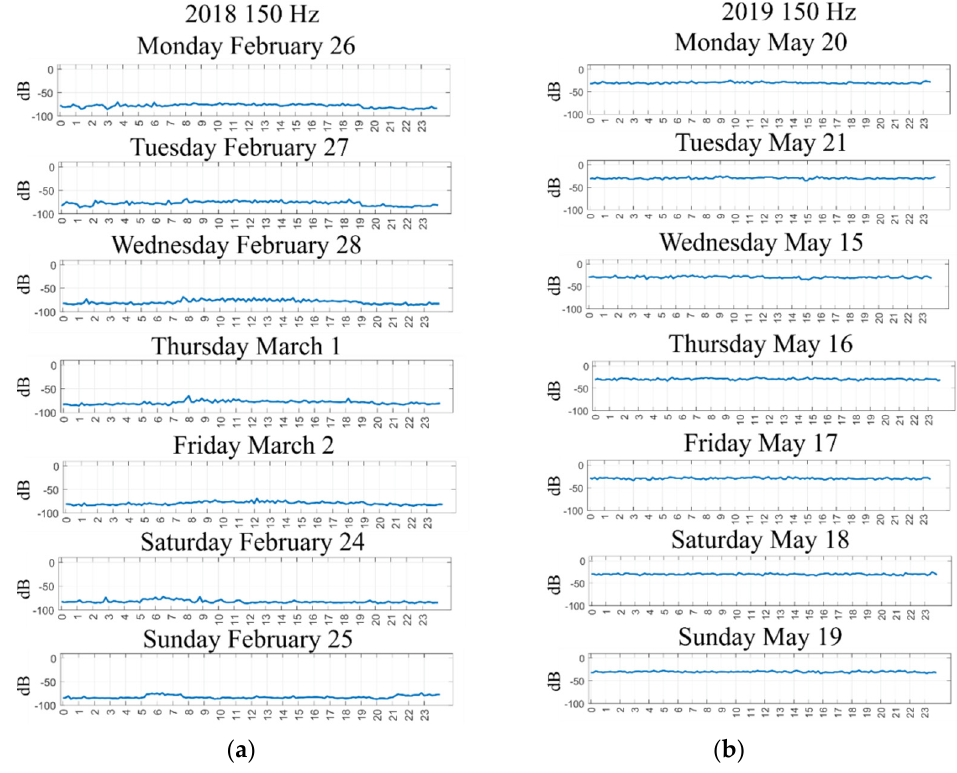
Figure 6. Amplitude behavior for the 3rd harmonic of the current signal ( a ) in 2018; and ( b ) in